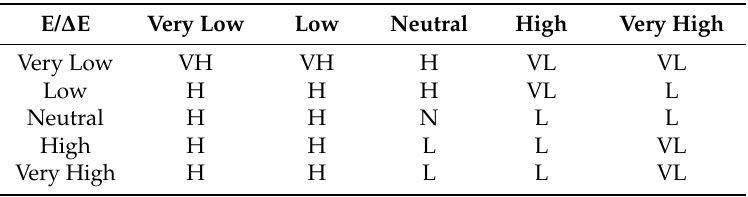
Table 4. Fuzzy associative matrix.